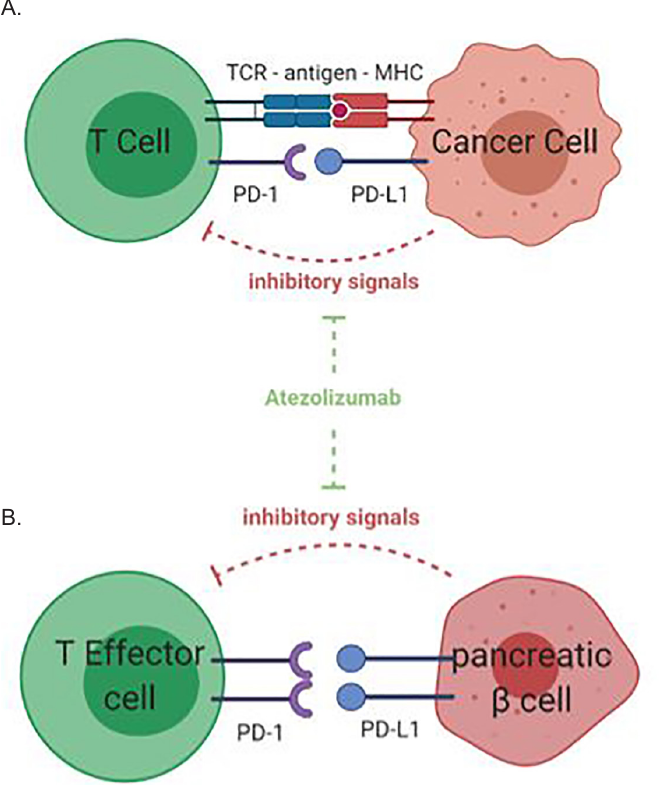
Figure. (A) Mechanism of anti- PD-L1, atezolizumab, on T-cell response to cancer cell. PD-L1 is expressed on cancer cells and inhibits T-cell activation when binding to the PD-1 receptor on T-cell surface. Anti-PD-1/PD-L1 treatment with atezolizumab leads to the inhibition of this inhibitory pathway and subsequent enhanced T-cell activity against tumor cells. (B) Mechanism of action of anti- PD-L1 agent on immune tolerance in the pancreas. PD-1/PD-L1 interaction between effector T cells and pancreatic insulin-secreting β cells inhibits T-cell activation against the pancreas. The anti-PD-L1 agent, atezolizumab, blocks the PD-1/PD-L1 interaction, leading to activation of self-reactive T cells and destruction of the pancreatic islet cells of Langerhans. This results in immunotherapy-induced autoimmune diabetes. Figures created with BioRender.com (Toronto, ON,